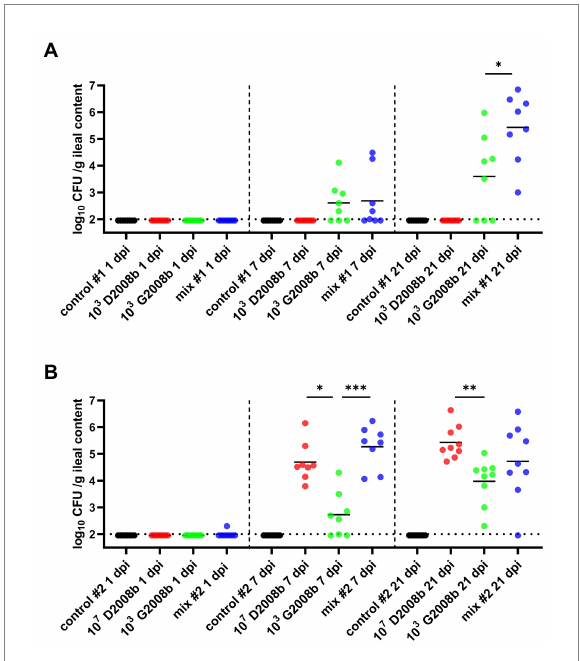
FIGURE 3 Total Campylobacter jejuni counts in ileal contents (log 10 CFU/g of ileal content) from birds at 1, 7, and 21 dpi for room 1 (A) and room 2 (B) . Dots correspond to individual birds. Horizontal bars represent median values, and horizontal dotted lines denote the threshold (2 log 10 CFU/g of ileal content). Due to the low number of birds colonized at 1 dpi, statistical analyzes were not performed. At 7 and 21 dpi, statistical analyzes were conducted using a Mann–Whitney test (A) and a Kruskal-Wallis test followed by Dunn’s post-hoc tests with Bonferroni adjustments (B) to compare median values between colonized groups according to the time point and room. *, ** and *** indicate p <0.05, p <0.01 and p <0.001